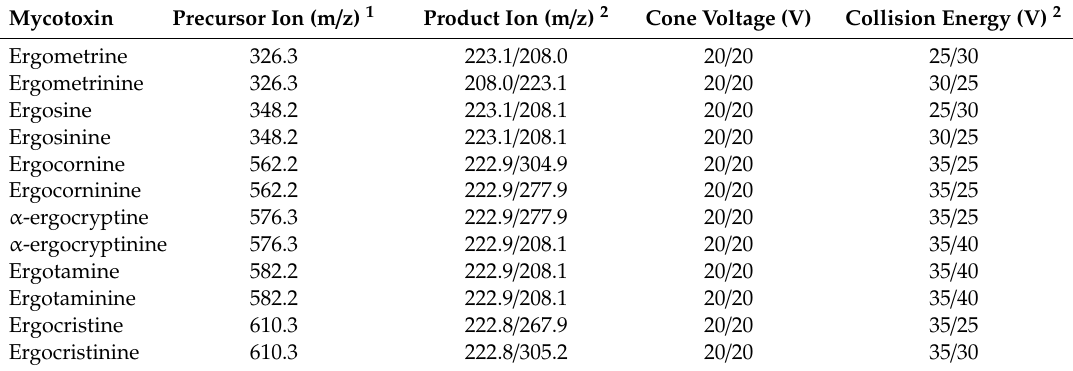
Table 1. Optimized mass spectrometric (MS / MS) parameters for the selected ergot alkaloids